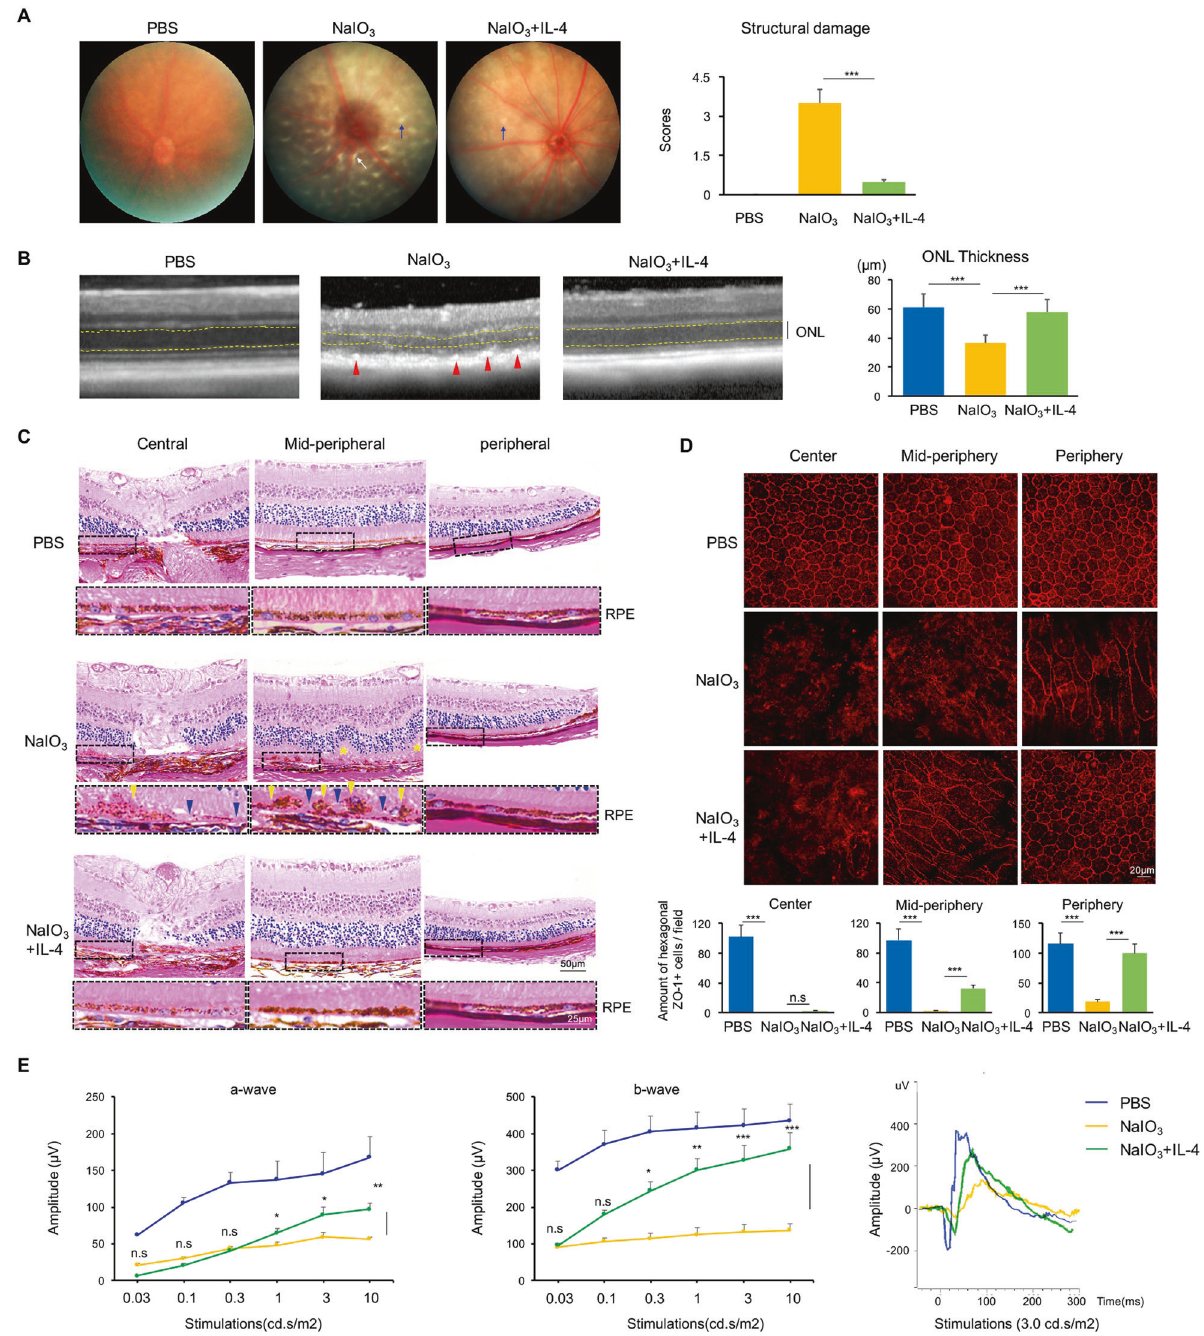
Fig. 2 IL-4 protected neuroretinal structure and function in the NaIO3-induced retinal degenerative mice. A The funduscopy of NaIO 3 - induced degenerative retina was characterized by pale appearance and some dot-like or linear lesions showing structural damage (blue arrows), which were alleviated after IL-4 treatment. n = 6. B Representative images of the OCT scanning. The NaIO 3 model demonstrated obvious discontinuity of RPE layer with high-re fl ective deposits (red arrows), while IL-4-treated RPE exhibited as a smooth, continuous, and uniform re fl ectiveness layer. The ONL thickness (distance between yellow lines) was calculated and compared. n = 6. C H&E staining showed crumby-structure patches and melanin rich aggregation in the RPE layer of the NaIO 3 -retina, particularly in the mid-peripheral locations. After IL-4 treatment, the RPE layer was preserved and well-organized with less melanin rich aggregation and the retinal folds were relieved. Scale bar: 50 μ m and 25 μ m. D Representative images of RPE fl at-mount in the center, mid-periphery and periphery areas sheet showing RPE integrity by ZO-1 staining. NaIO 3 disrupted the well-organized hexagonal-shaped RPE cells, whereas IL-4 treatment could preserve it with more organized barrier structures speci fi cally in the mid-periphery and periphery areas. Statistical analysis showed the amount of ZO-1 + cells. n = 6, Scale bar: 20 μ m. E ERG examinations showed a- and b-waves were almost extinct in NaIO 3 -retina. However, IL-4 treatment protected the neuroretinal functions with increased amplitudes of both a- and b-waves. n = 6. Data are shown as mean ± SEM, *** P < 0.001, n.s: not signi fi cant, one-way ANOVA